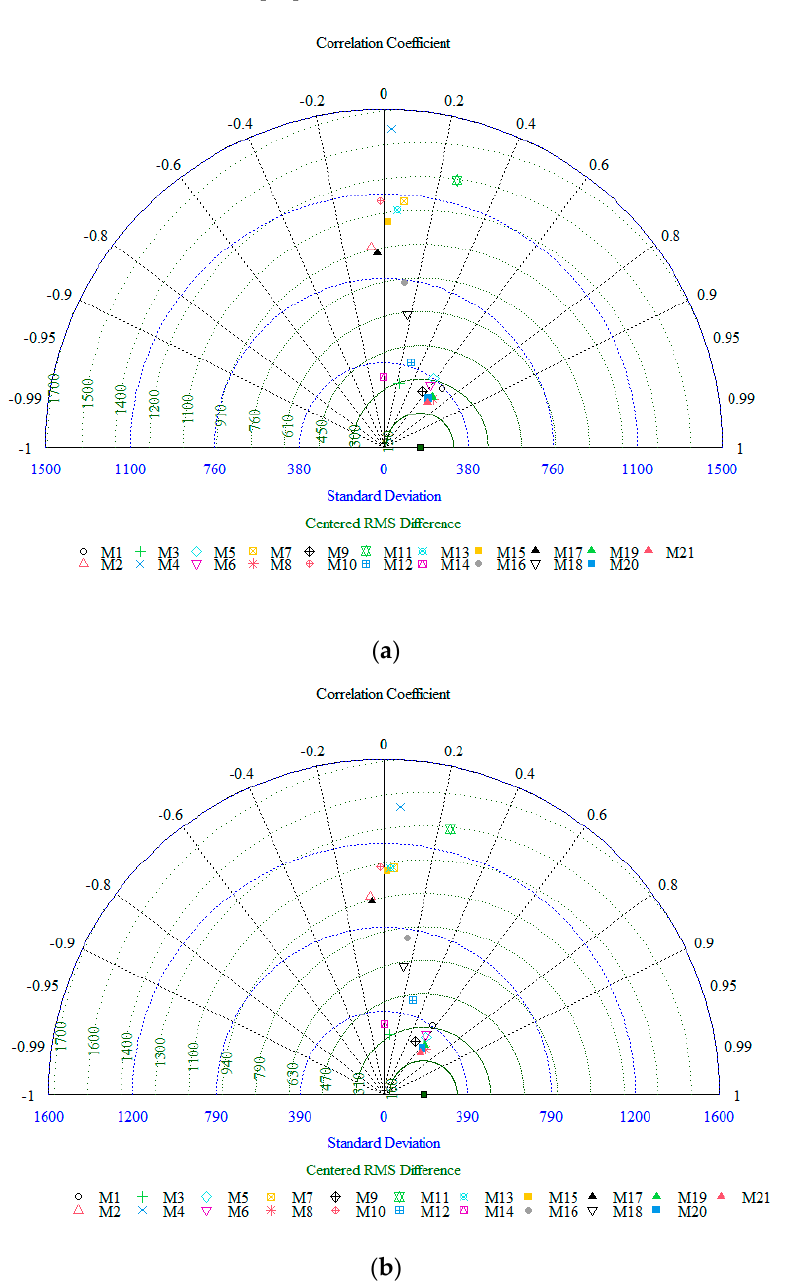
Figure 6. Grid-based comparison result for all climate models using observed data as a reference and for the historical period (1986–2016) in ( a ) and validation period (2006–2016) in ( b ).